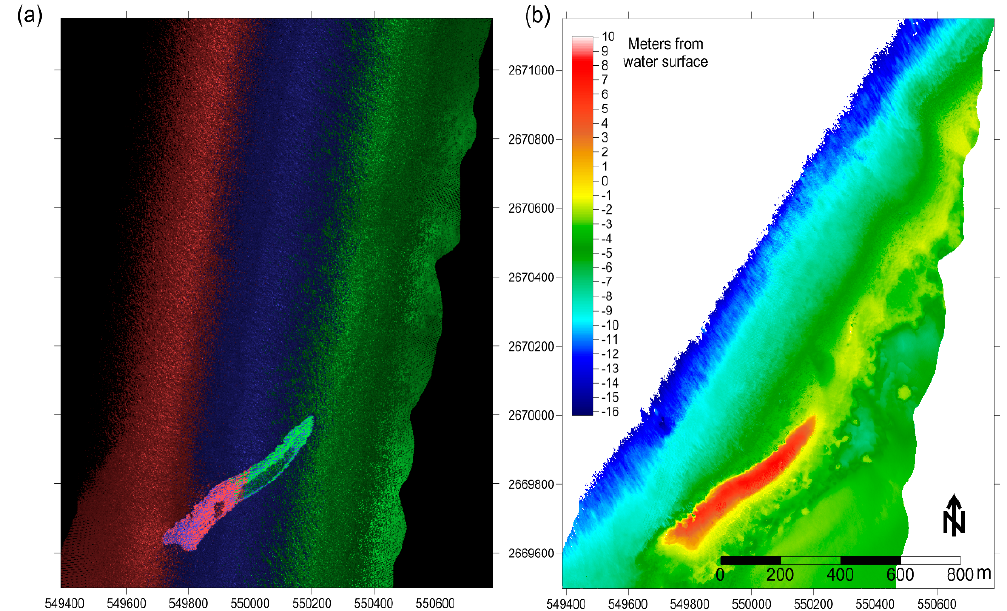
Figure 9. Small sample of a bathymetric survey surrounding the Green Cay, Bahamas: ( a ) Rendering of the point cloud of the first returns of the bathymetric channel colored by flight line and intensity; ( b ) Topographic and bathymetric color map showing water depths and island elevations.